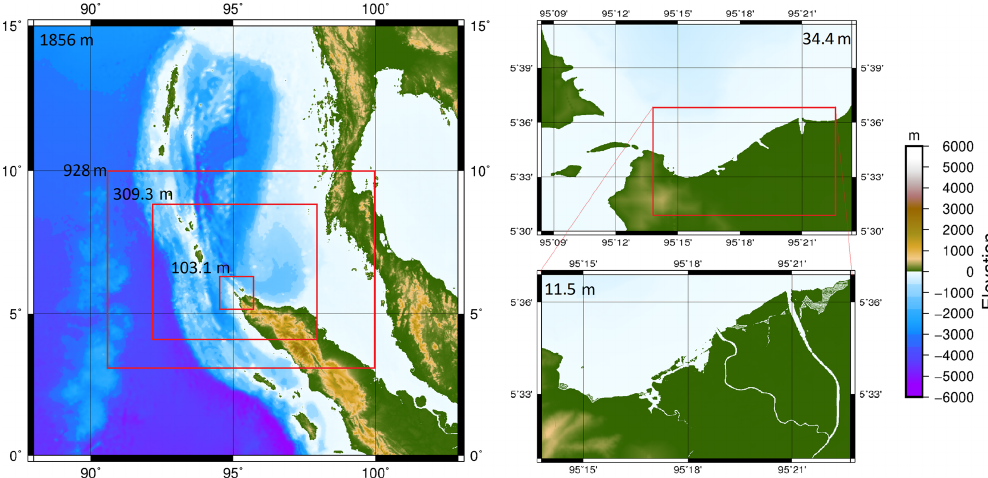
Figure 4. Six simulation layers and the size of the grids (written in each layer) applied in COMCOT. Table 1. Information on the setup of the six layers for the COMCOT simulations. Layer Latitude Longitude Number Ratio Grid Time Manning’s roughness SWE type of grid size (m) step (s)